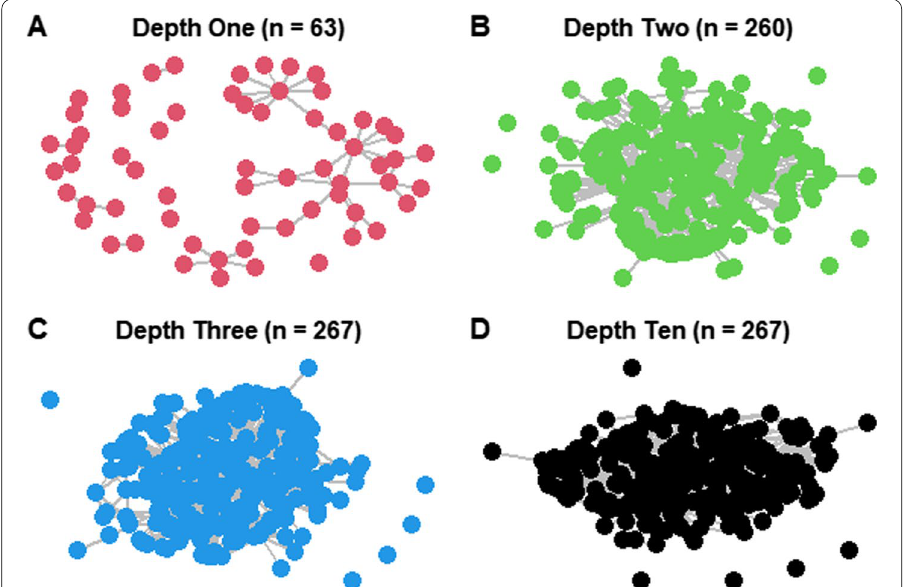
Fig. 2 Network diagrams for the reduced root URL network at depths one, two, three, and ten, panels A – D respectively. New nodes were not added past depth three, thus depths four through nine are omitted for clarity and depth ten is shown for comparison. Nodes represent websites and edges represent hyperlinks from one site to